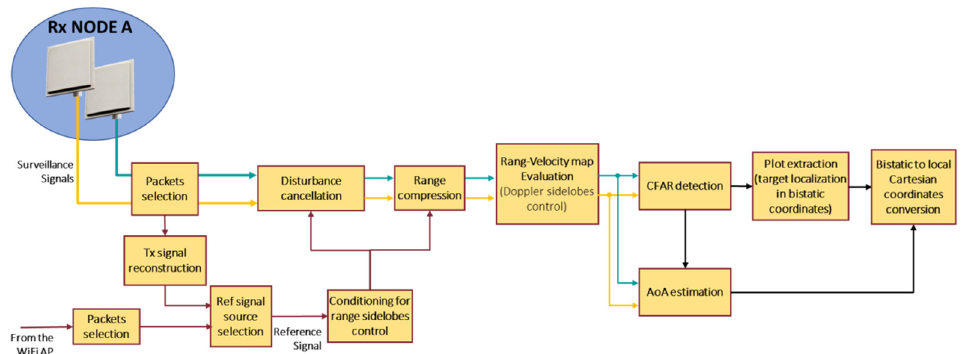
Figure 2. Processing scheme of the PBR exploiting a single node with two surveillance antennas.